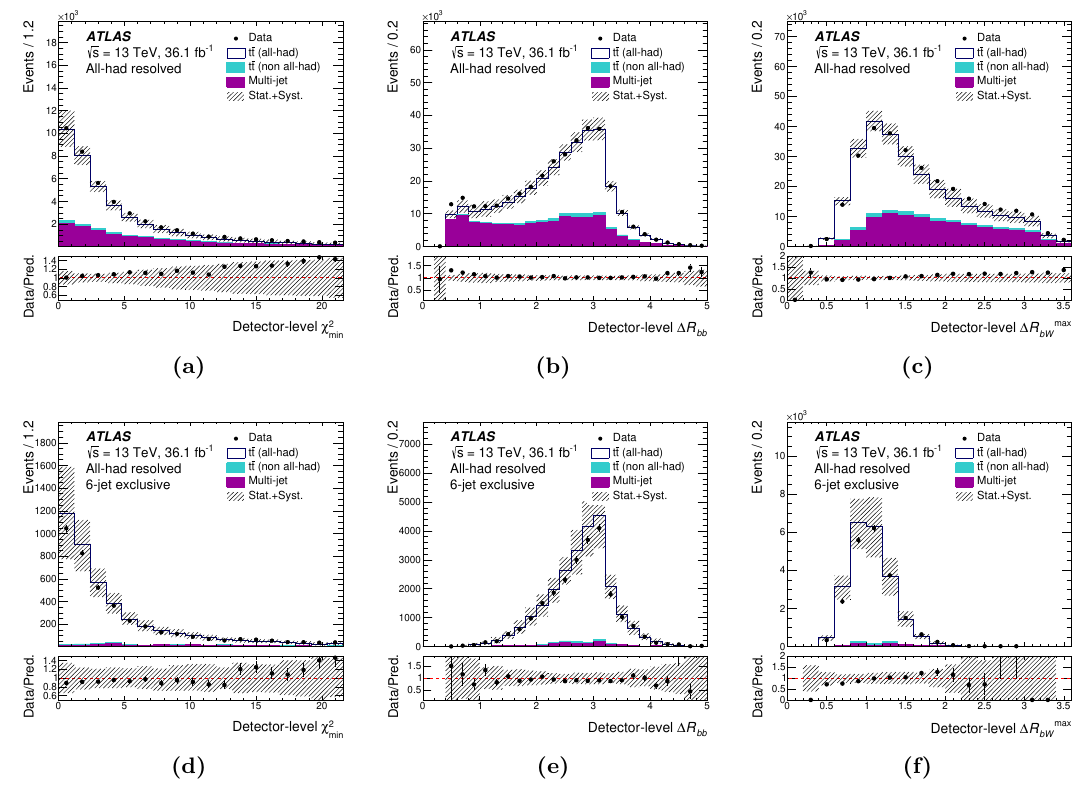
Figure 1 . Detector-level distributions in the signal regions as a function of the (left) χ 2 ∆ R and (right) ∆ R max , for (top) all selected events and (bottom) exclusive six-jet events. The bb bW signal prediction is based on the Powheg+Pythia 8 generator. The background is the sum of the data-driven multi-jet estimate and the MC-based expectation for the contributions of non-all- hadronic t ¯ t production processes. Statistical uncertainties combined with the combined systematic uncertainties for the applied selection are shown in hatching. Data points are placed at the centre of each bin and overflow events are included in the last bins.